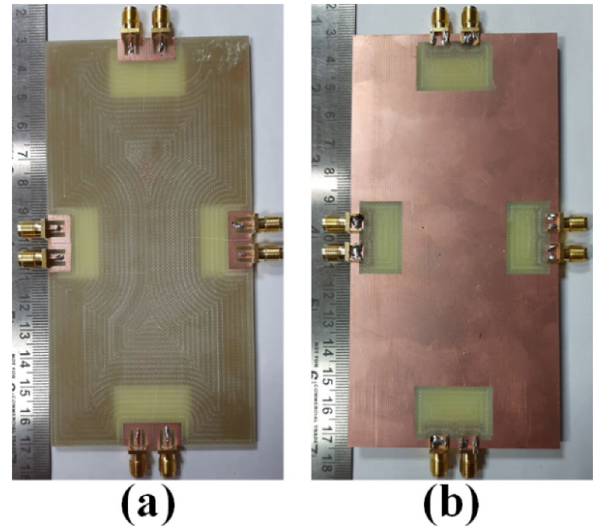
Figure 20. Design sample prototype of 8 Members MIMO (M-shaped) antenna ( a ) Front view, ( b ) Rear view.